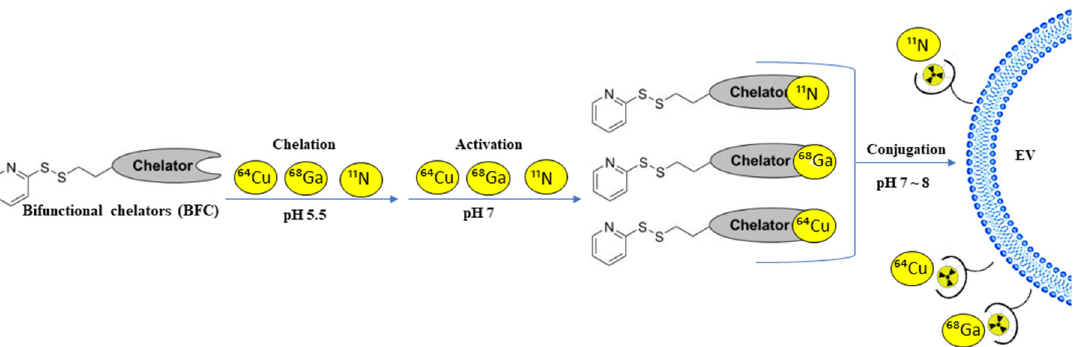
Figure 5. A schematic overview of conjugating bifunctional chelators (BFC) on the EVs membrane surface.